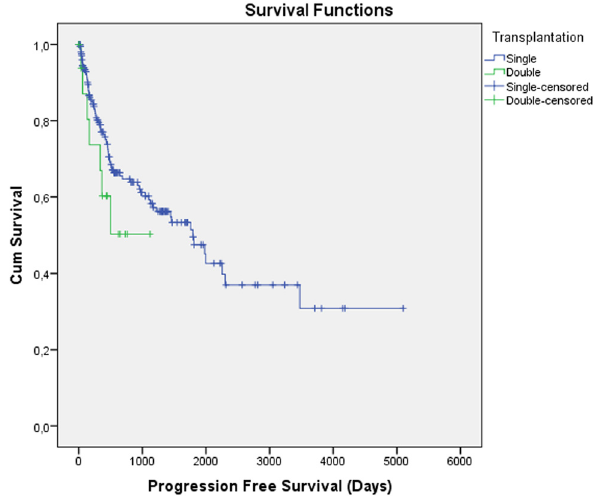
Figure 2: There is no statistically signi fi cant progression - free survival duration di ff erence between the single and double transplanted groups ( 2,344 ± 228 vs 685 ± 120 days, respectively, p : 0.22 )